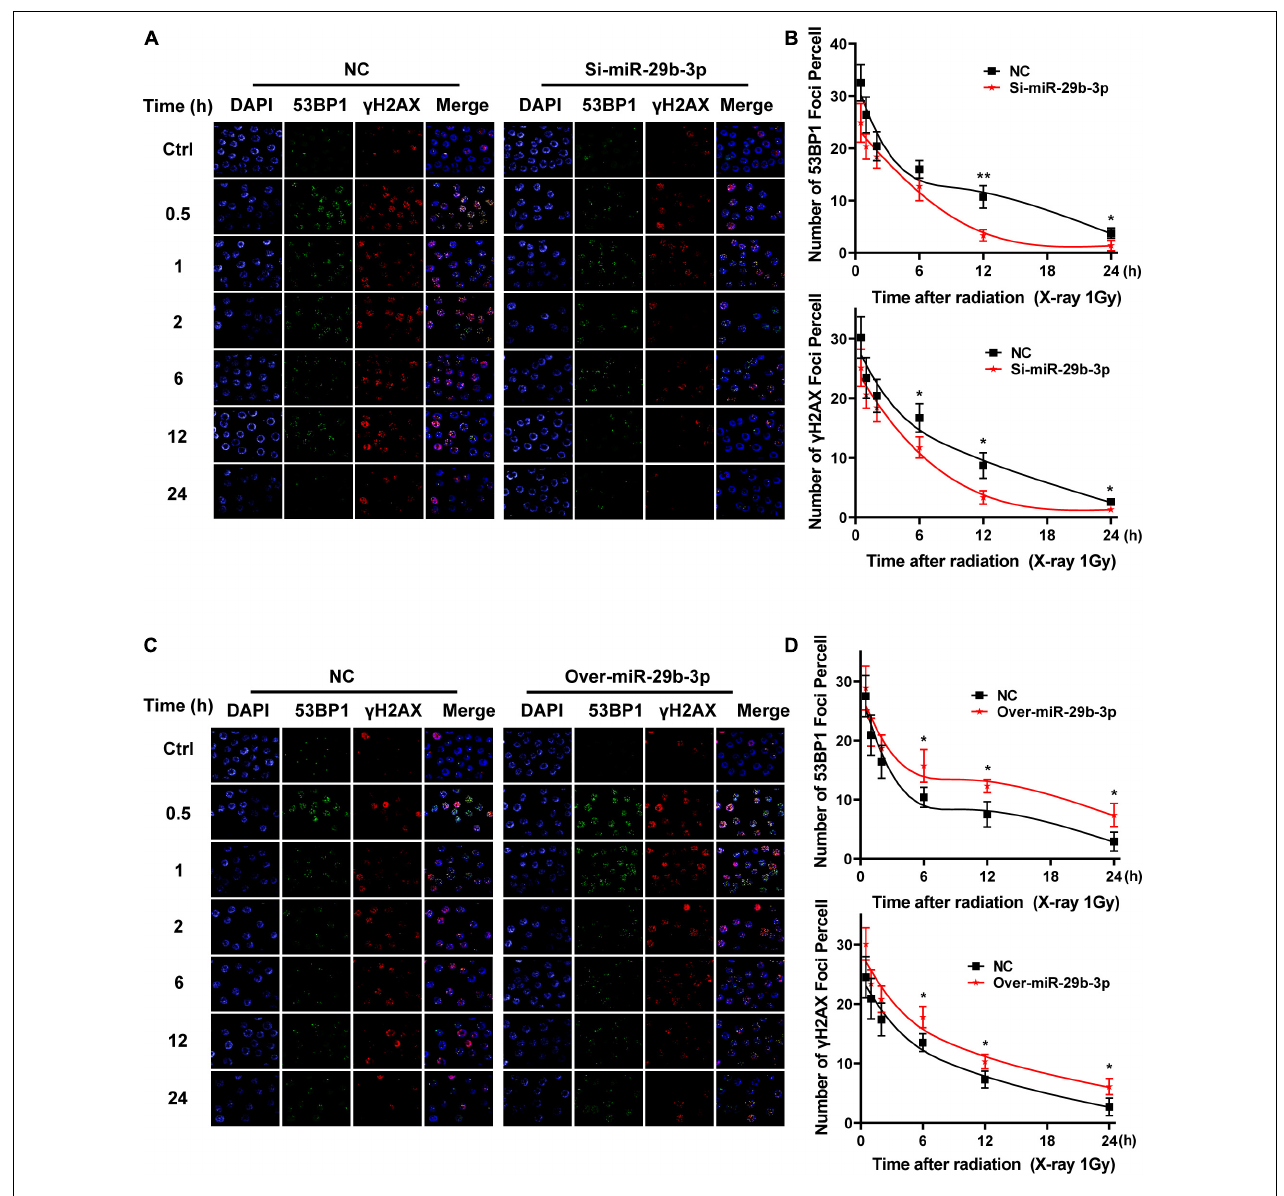
FIGURE 6 | Kinetics process of DNA damage repair in miR-29b-3p knockdown or overexpressed A549 cells. (A) Graph shows quantification of 53BP1 and yH2AX foci in miR-29b-3p knockdown and negative control A549 cells exposed to 1 Gy X-ray. (B) The numbers of 53BP1 and yH2AX foci in 50 cells of each group were counted for each time point. (C) Graph shows quantification of 53BP1 and yH2AX foci in miR-29b-3p overexpressed and negative control A549 cells exposed to 1 Gy X-ray. (D) The numbers of 53BP1 and yH2AX foci in 50 cells of each group were counted for each time point. Ctrl, unirradiated groups; NC, negative control. Significance was determined by unpaired t -test. * P < 0.05; ** P <